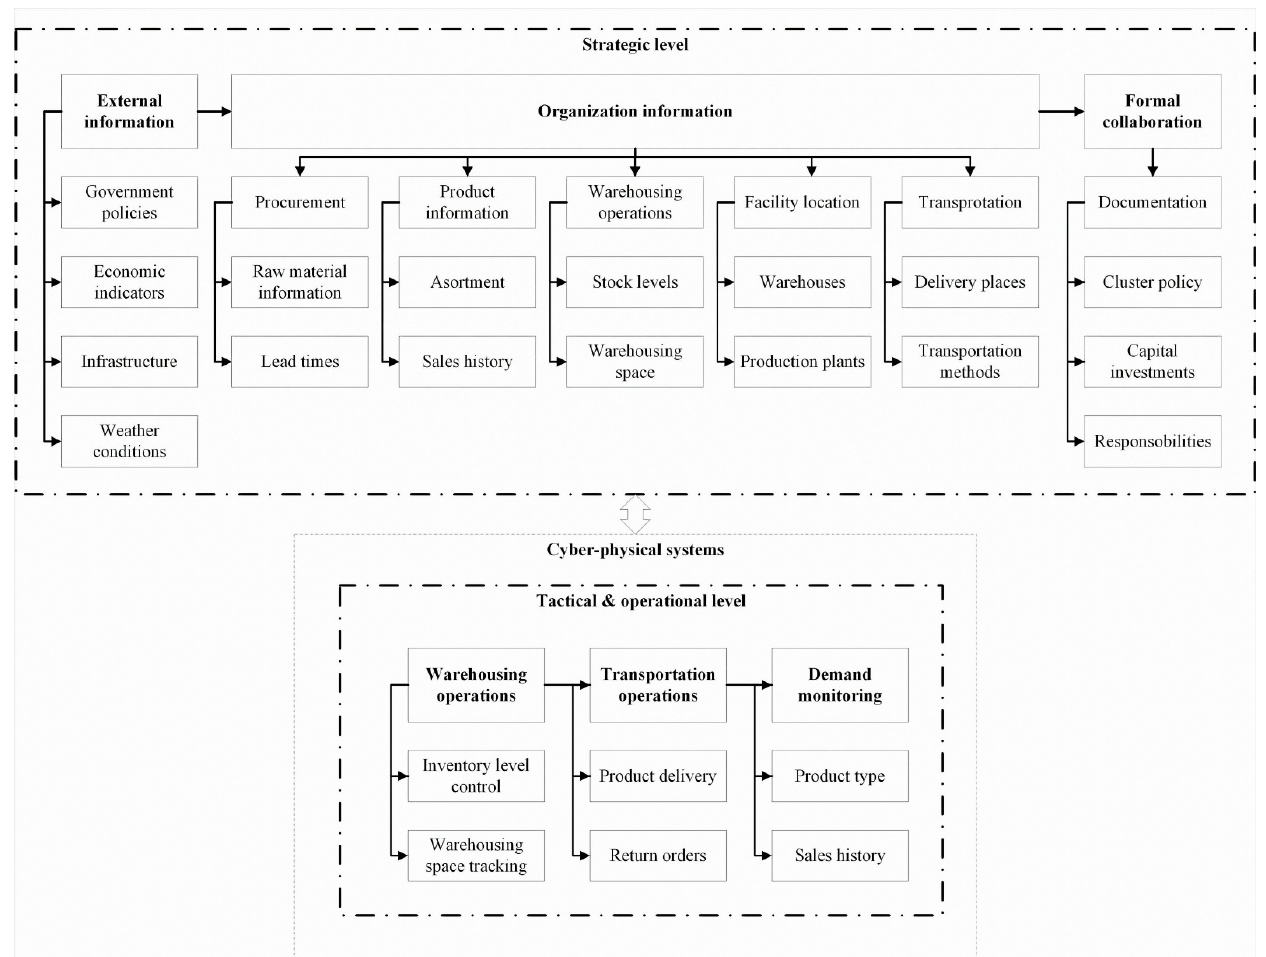
Figure 2. Conceptual model of integration of strategic, tactical and operational levels, created by authors.